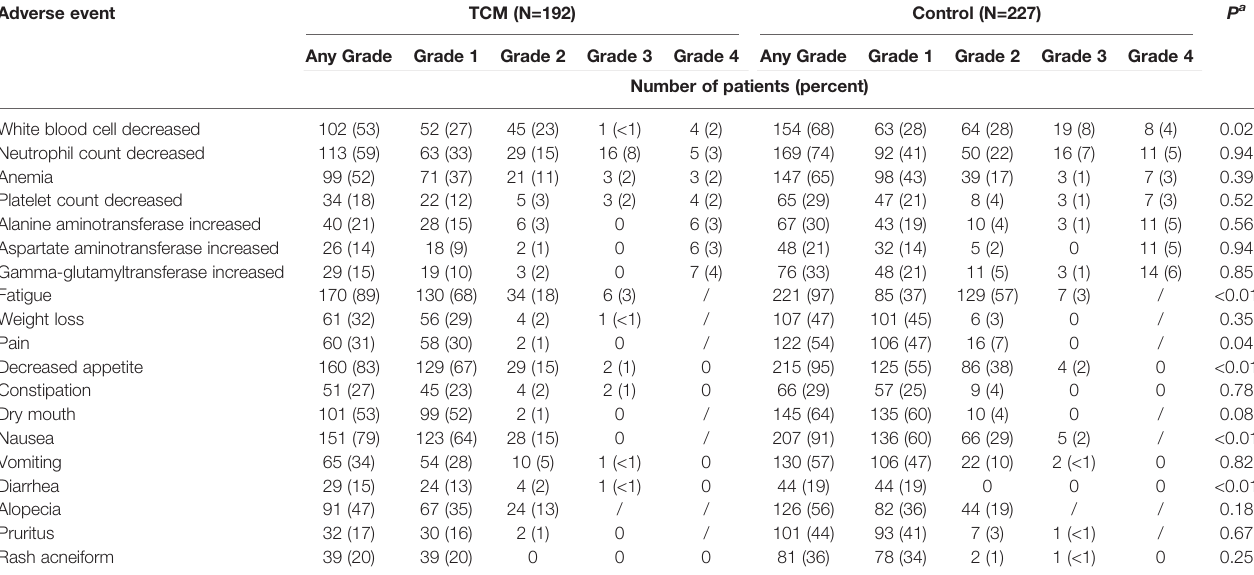
TABLE 3 | Adverse Events. Adverse event